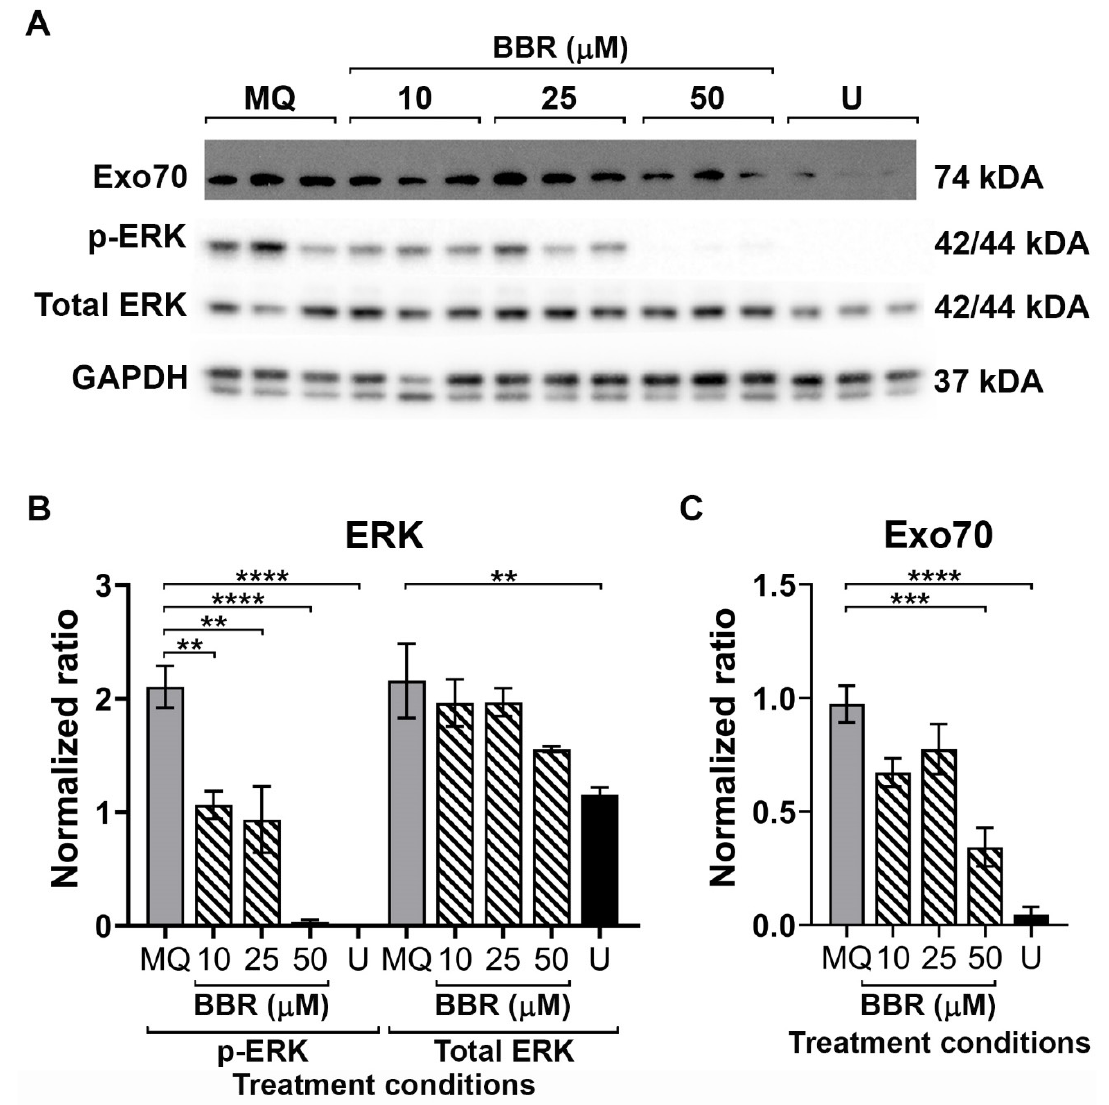
Figure 4. Effect of BBR on Erk1/2 and Exo70. BHK-21 cells were either treated with vehicle, U0126 or BBR at 10, 25 or 50 µM for 24 h, after which cells were collected and proteins prepared. ( A ) Expression levels of Exo70, p-Erk1/2, total Erk and GAPDH were determined by western blotting. ( B , C ) Band intensities from ( A ) were quantitated and normalized against GAPDH. Experiment was undertaken independently in triplicate. Error bars show ± S.E.M. ** p ≤ 0.01 *** p ≤ 0.001, **** p ≤